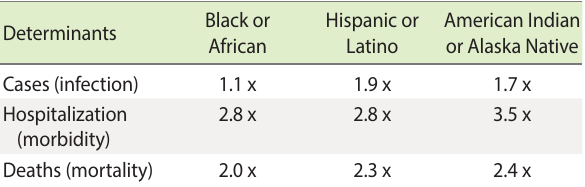
Table 1. Risk for coronavirus disease 2019 infection, hospitalization, and death by race/ethnicity in the United States compared to